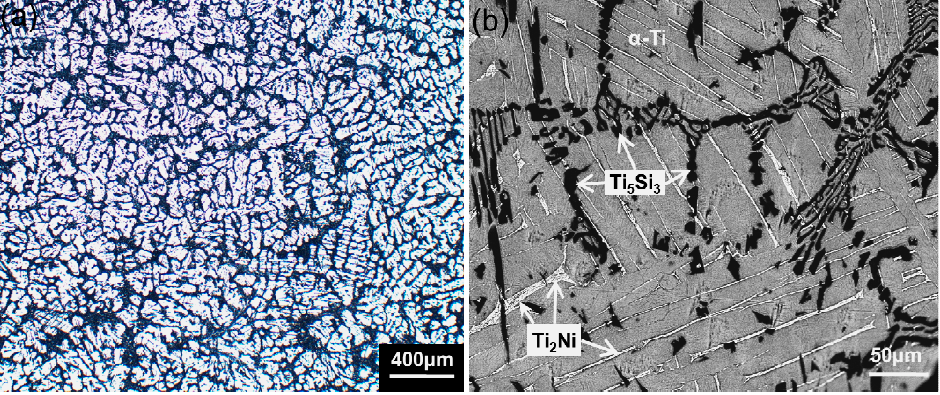
Figure 1. Typical microstructure of Ti-1Ni-5Si alloy: ( a ) Optical micrograph; ( b ) SEM image. Table 1. Compositions of the α -Ti phase, Ti 2 Ni phase, and Ti 5 Si 3 phase of the alloy. EDS Testing